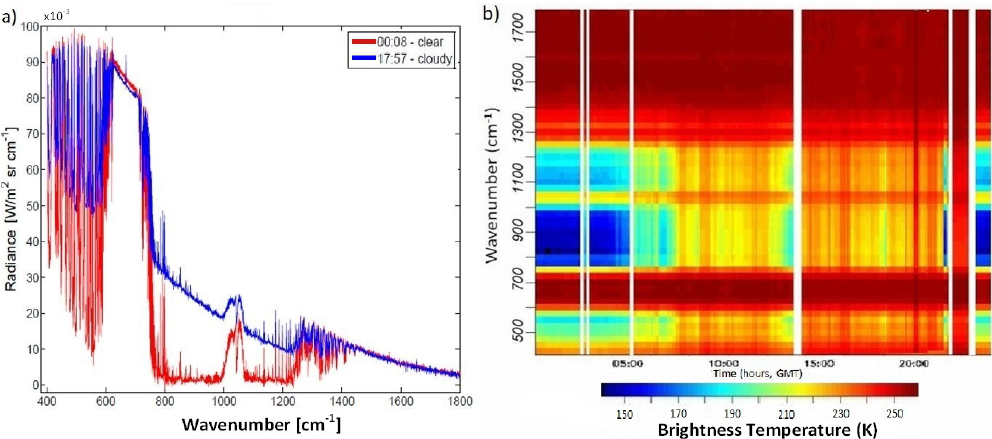
Fig. 6. (a) E-AERI measurements of radiance on 16 April 2009 at 00:08UTC (red) and 17:57UTC (blue). (b) Brightness temperatures measured throughout 16 April 2009. White spaces correspond to periods of no measurement (instrument reboot, precipitation). Only the longwave spectral region (up to 1800cm − 1 ) is shown for clarity.